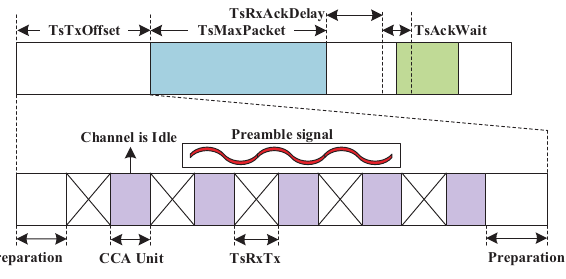
Figure 5. The structure of a CE (clear channel assessment-embedded) slot for the transmitting